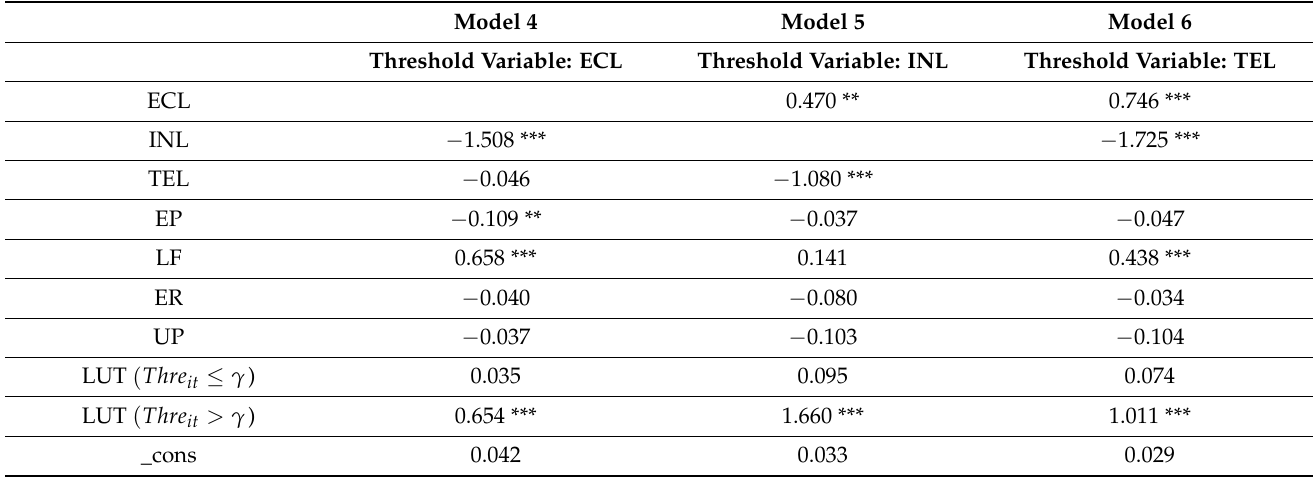
Table 7. Estimation of threshold effects of carbon source